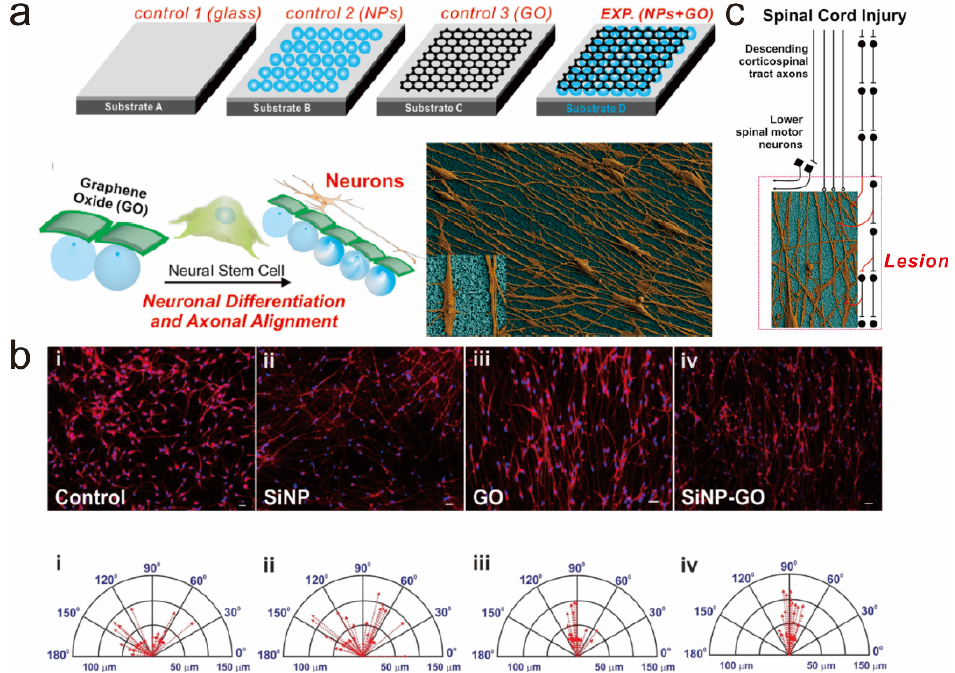
Figure 6. ( a ) Schematic diagram representing the effects of GO ‐ coated nanoparticle hybrid construct on the differentiation of hNSCs and the alignment of the axons of differentiated